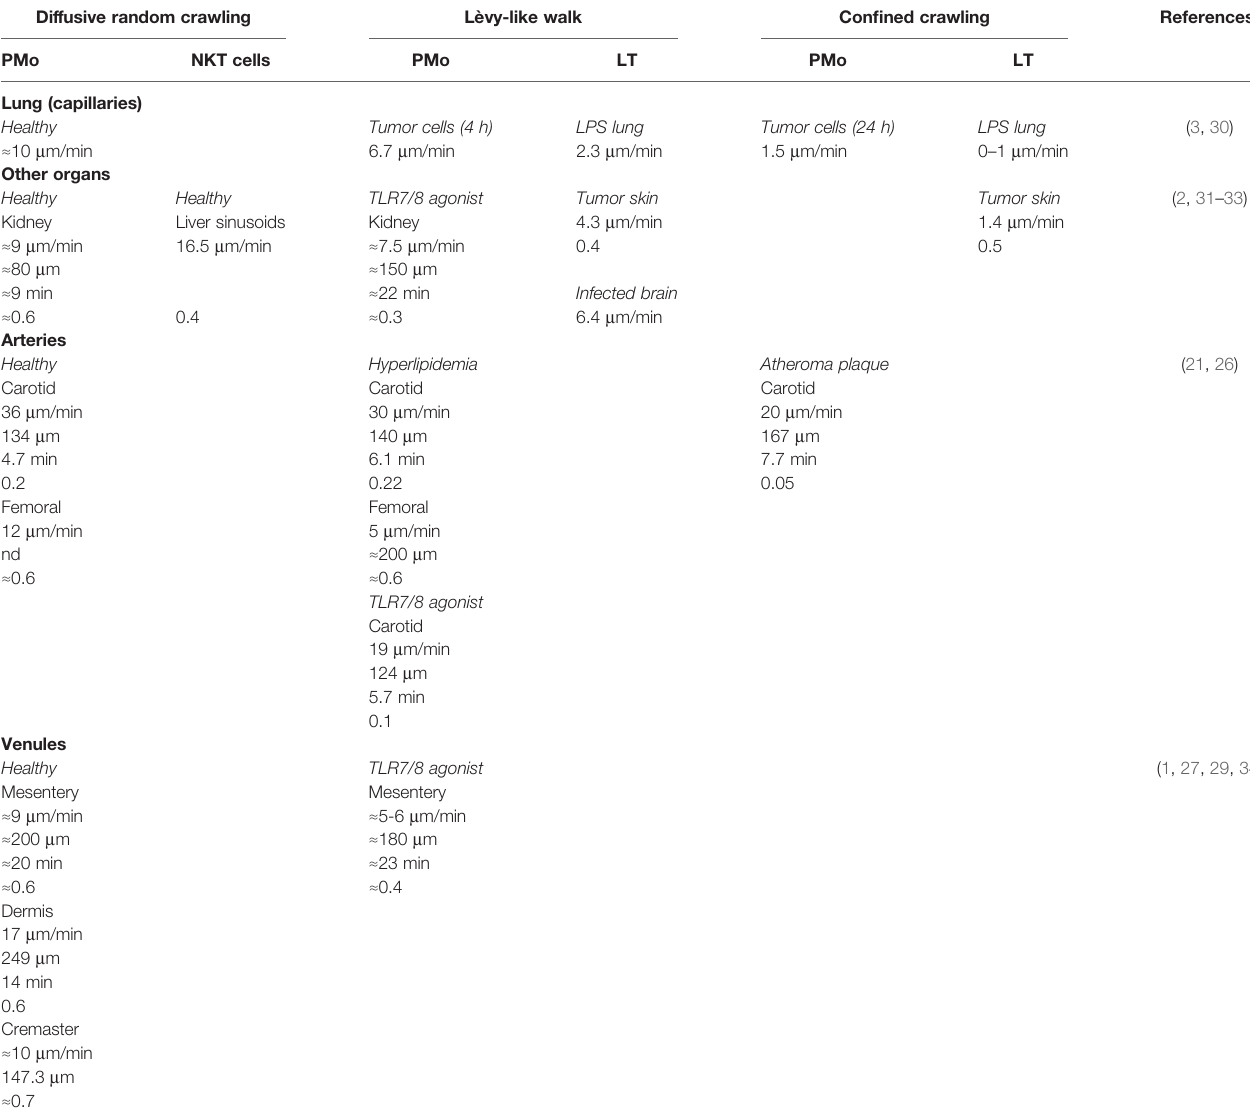
TABLE 1 | Cellular kinetic parameters of the proposed crawling modes in various territories and conditions: mean speed ( m m/min), length ( m m), duration (min), and straightness (distance traveled/length of the trajectory). Diffusive random crawling Lèvy-like